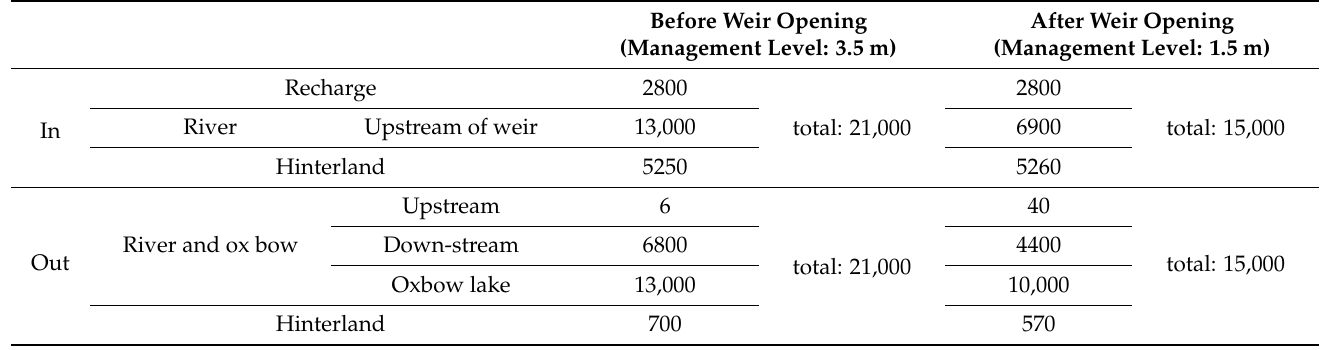
Table 1. Water balance in the study area (m 3 /day).